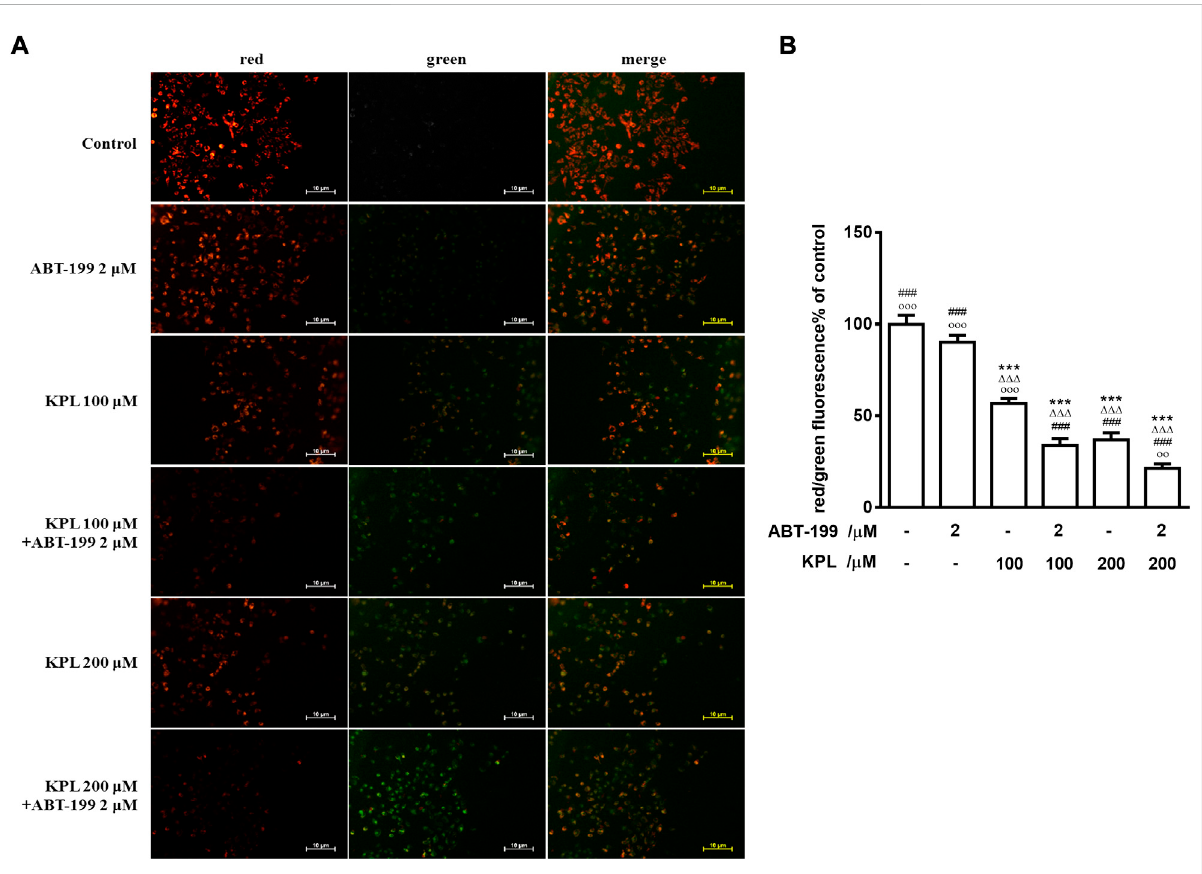
The effect of KPL combined with ABT-199 on mitochondrial membrane potential of HepG2 cells. (A) Representative images of double immuno fl uorescentstainingforJC-1.DifferentconcentrationsofKPLwithorwithout2 μ MABT-199weretreatedonHepG2cellsfor24 h,andthen the changes of mitochondrial membrane potential were detected with JC-1 dye. The negative group was untreated. The images were collected by inverted fl uorescence microscope. Magni fi cation=100×. (B) The ratioofredandgreen fl uorescenceintensity.Valuesaremeans± SD( n